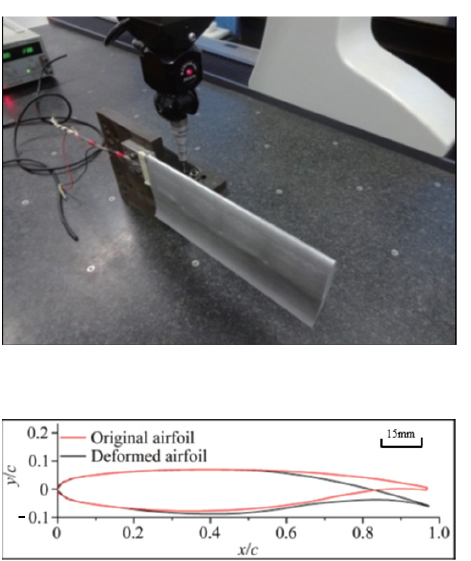
Figure 9. Ground measuring results by coordinate measuring machines without aerodynamic load- ing.